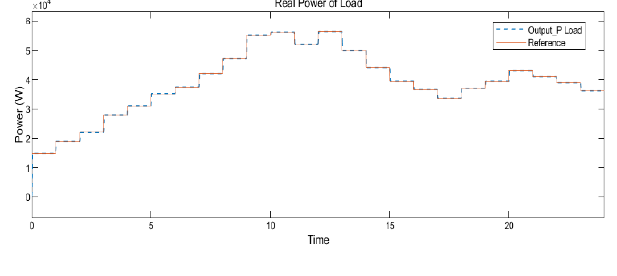
Fig.7. Output Real power of load